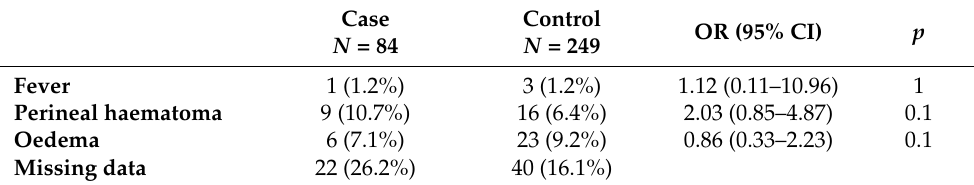
Table 3. Patient characteristics at the maternity ward.